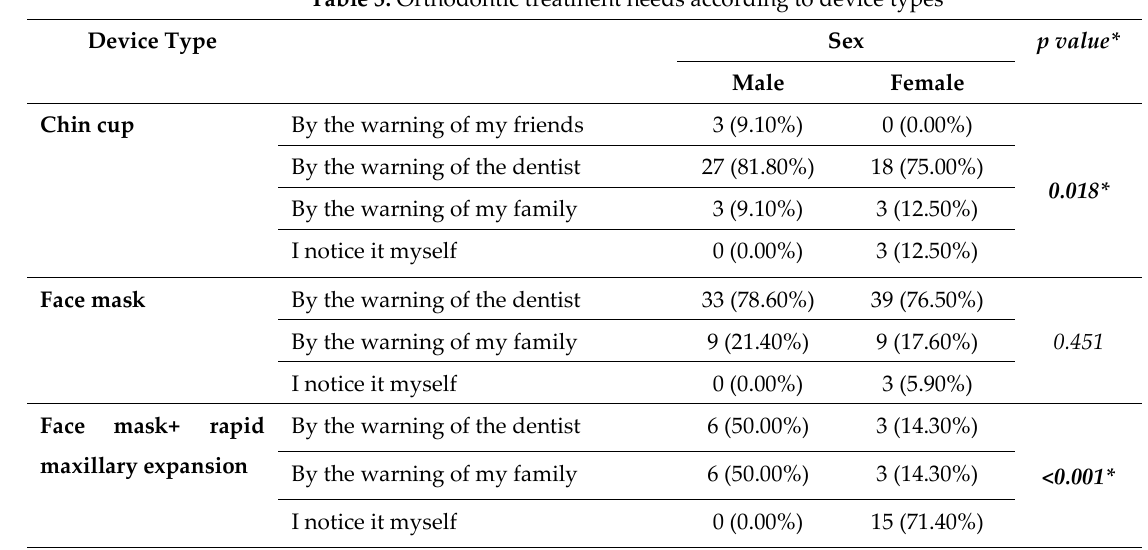
Table 5: Orthodontic treatment needs according to device types